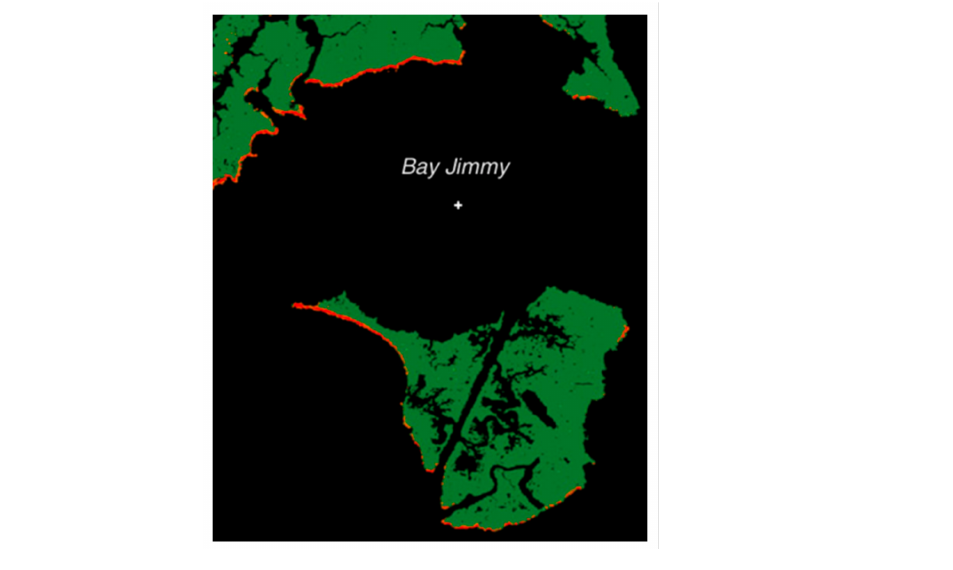
Figure 12. Oiled shorelines mapped from the same Aviris image [15].